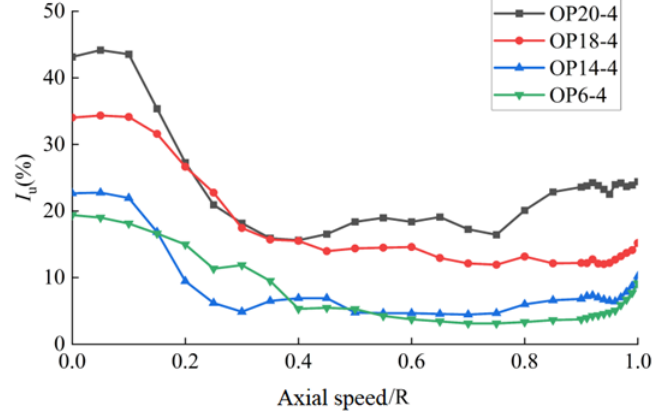
Figure 10. Turbulence intensity distribution in turbine mode.